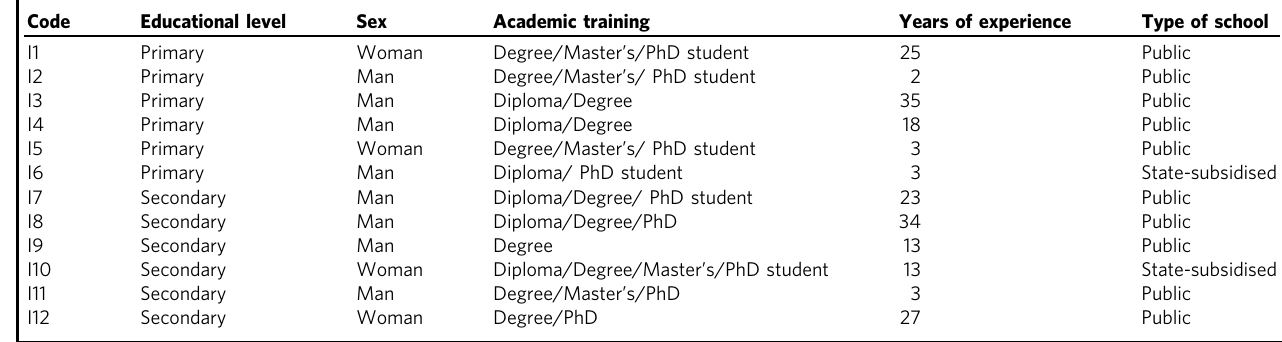
Table 2 Socio-demographic characteristics of the teachers interviewed.